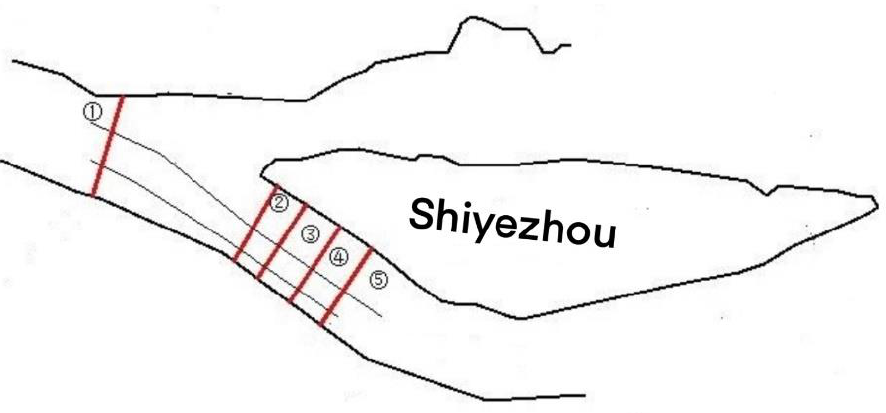
Figure 12. Positions of the sections of Shiyezhou Waterway before the project.